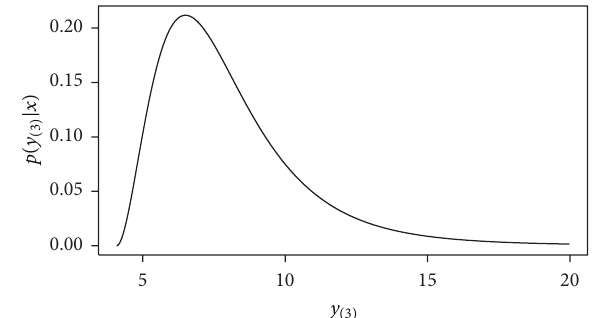
Figure 4: Two-sample predictive density function when 𝑘 = 1 for complete real data set.